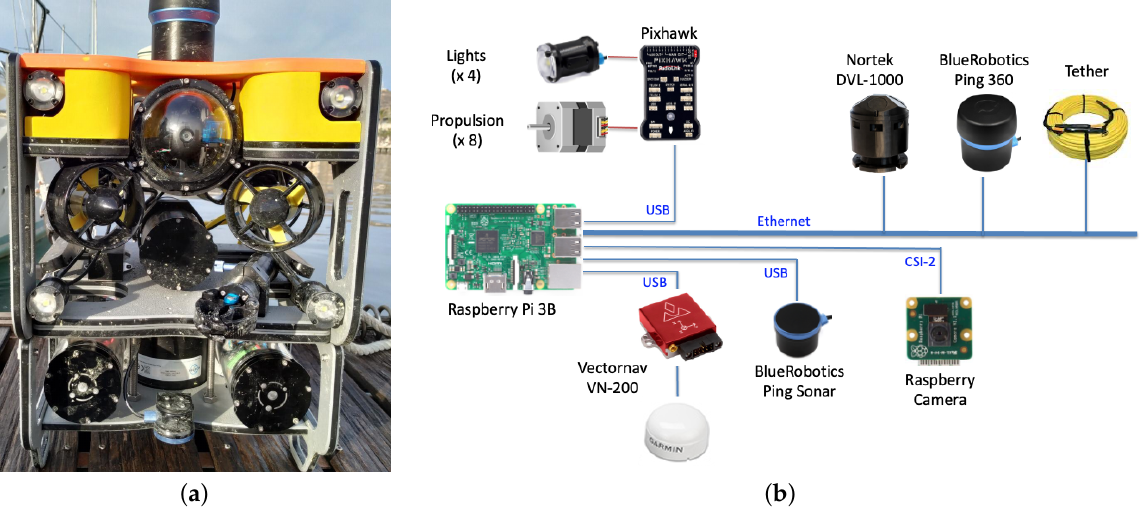
Figure 1. ( a ) Modified Sibiu Pro underwater vehicle from Nido Robotics company, and ( b ) hardware architecture and sensory